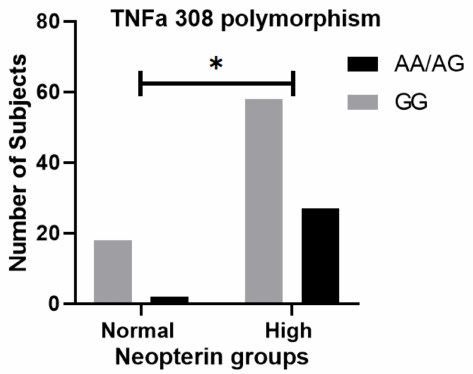
Figure 2. TNF α -308AA/AG polymorphism and neopterin level. TNF α -308AA/AG polymorphism was more common in children with elevated neopterin than TNF α -308GG (chi-square, p = 0.05). Of note, * means p < 0.05.